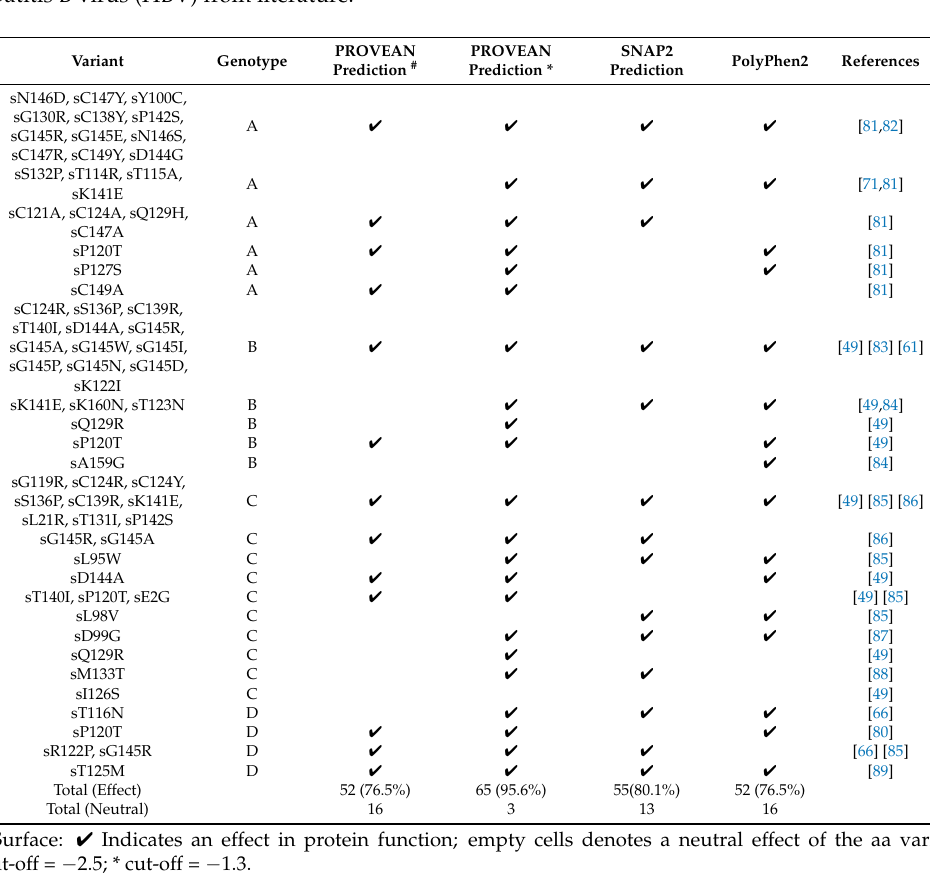
Table 1. Predicted effects of functionally characterized deleterious mutations of the surface region of hepatitis B virus (HBV) from literature.